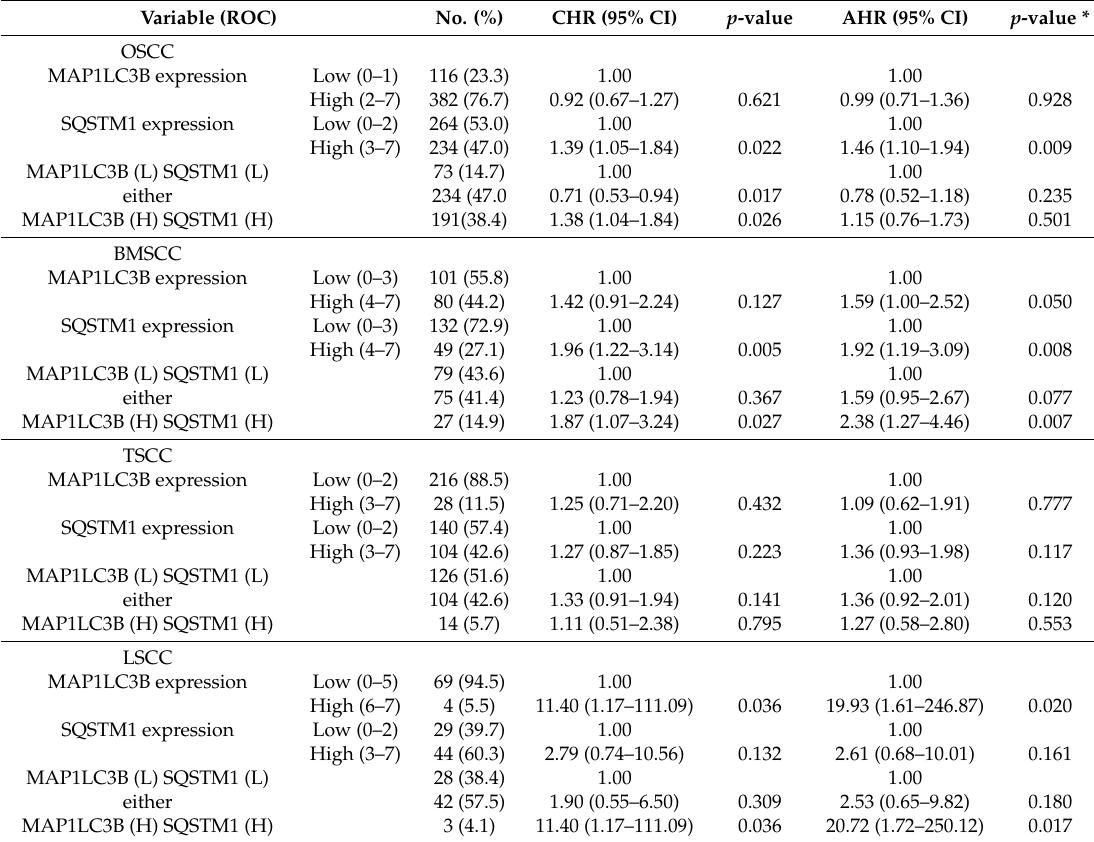
Table 5. The expression levels of MAP1LC3B and SQSTM1 in disease-specific survival of oral SCC